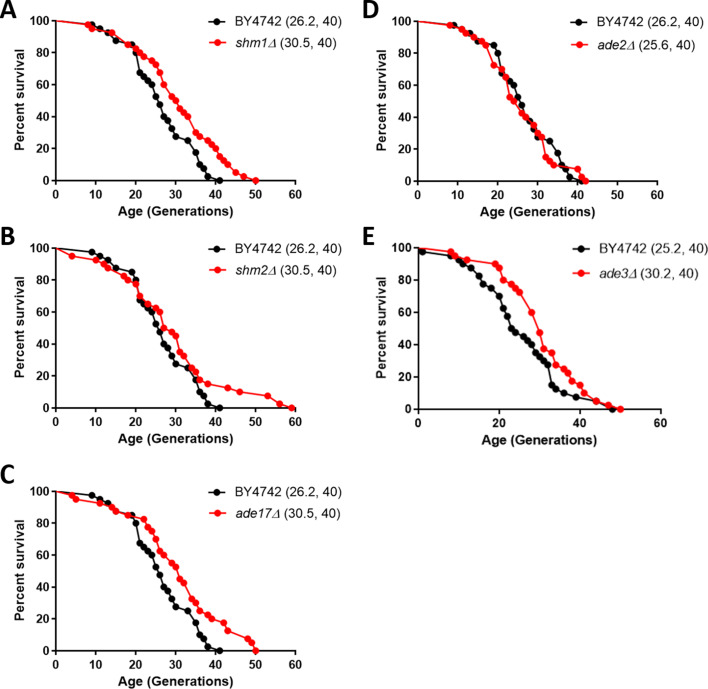
Deletion of enzymes of one-carbon metabolic pathways extends replicative lifespan in yeast.Survival curves for MATα (BY4742) cells (shown in black), compared to experiment-matched cells (shown in red) lacking SHM1 (A), SHM2 (B), ADE17 (C), ADE2 (D), or ADE3 (E). Mean lifespans are shown in parentheses, along with the number of cells assayed in each case. In the case of shm1Δ, shm2Δ, ade17Δ, and ade3Δ cells, the lifespan extension was significant (p<0.0001; based on the log-rank test).